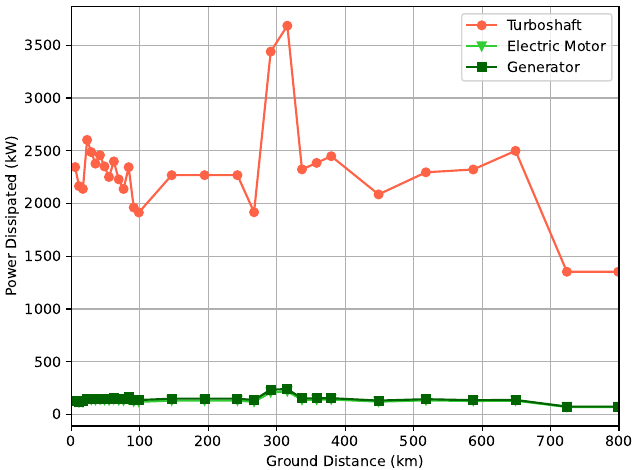
Figure 9. Power dissipated in the turboelectric propulsive